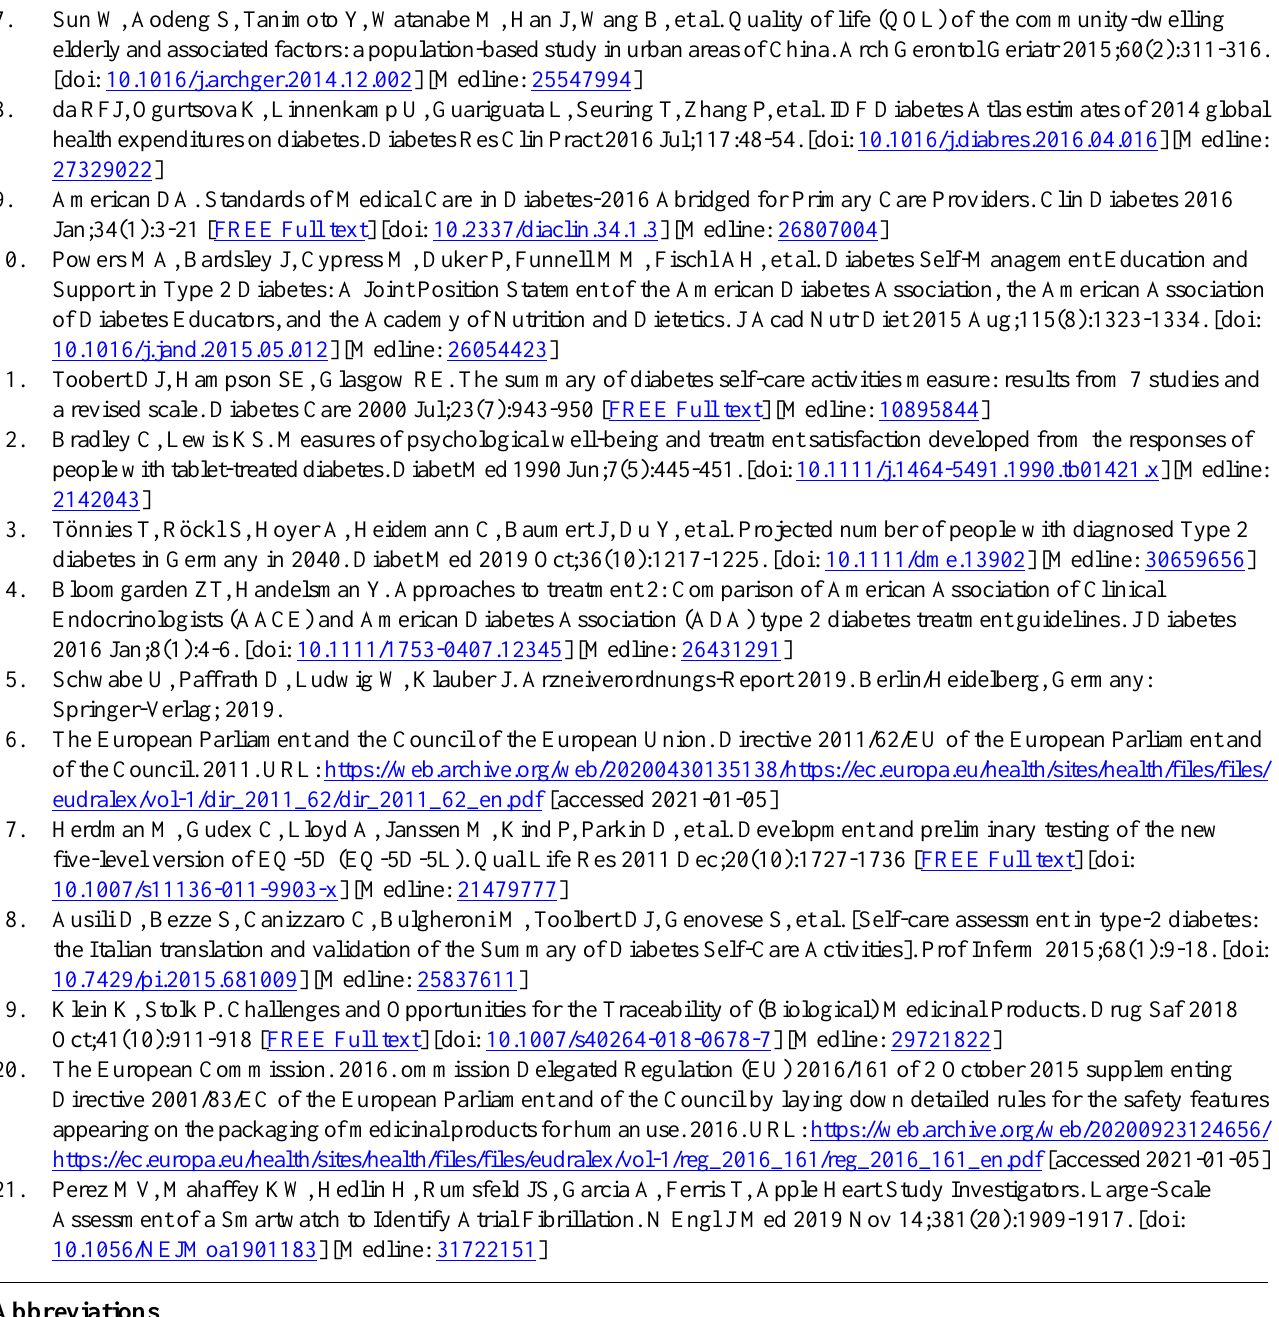
Abbreviations DM: diabetes mellitus DTSQ: Diabetes Treatment Satisfaction Questionnaire EQ-5D-5L: 5-level, 5-dimension EuroQol Questionnaire PRO: patient-reported outcome QR: quick response SDSCA: Summary of Diabetes Self-Care Activities VAS: visual analog